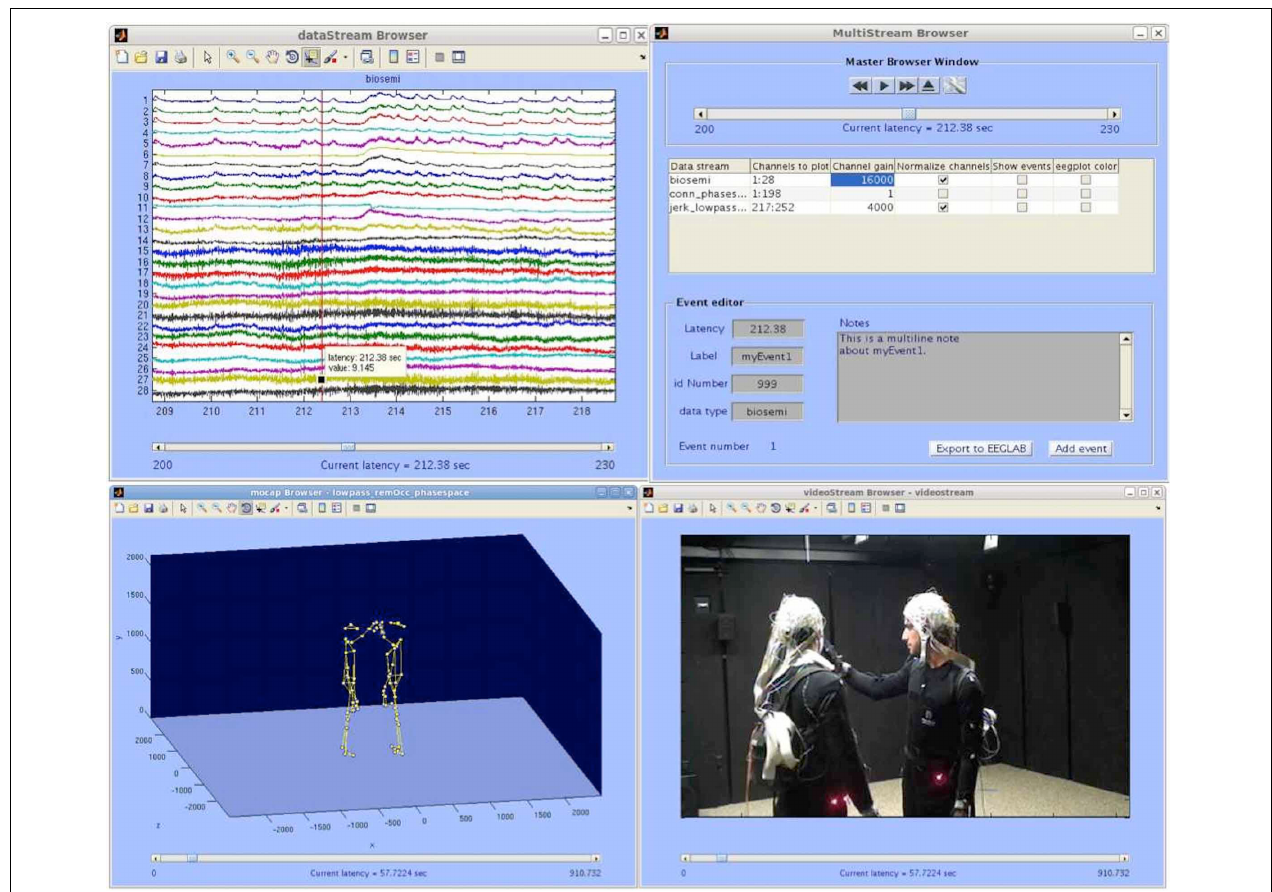
FIGURE 10 | MoBILAB multi-stream browser screen shot. Upper Left: Data stream browser (EEG, EMG, etc.). Upper right: Master browser window. Lower left: Motion capture browser. Lower right: Video stream browser. Picture, courtesy of the SCCN and Alejandro Ojeda.